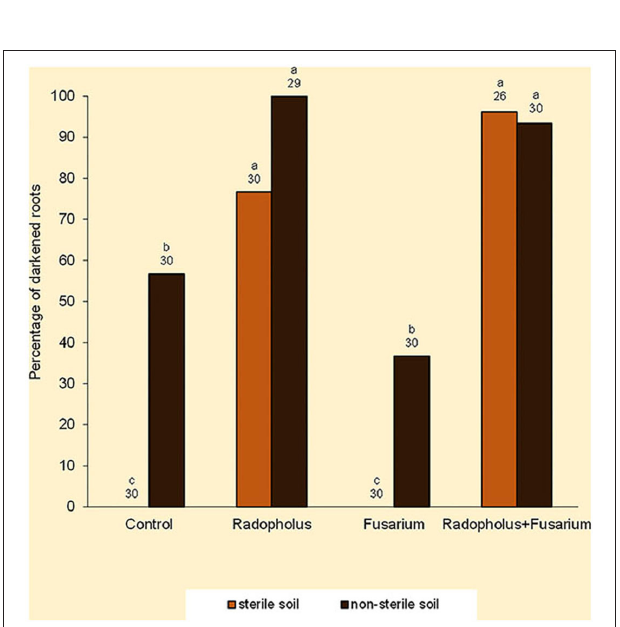
FIGURE 3 | Percentage of dark-colored roots in Nitrogen-starved tissue culture banana plants subjected to independent or combined inoculation with Radopholus similis and Fusarium oxysporum V5w2 and grown in sterile or non-sterile soil. Bars with the same letter represent values that are not statistically different, with the sample sizes indicated below the letters ( χ 2 -test, p <